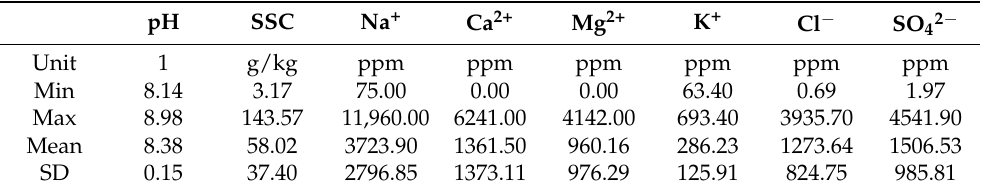
Table 1. Descriptive statistical parameters of the soil pH, SSC, and the contents of Na + , Ca 2+ , Mg 2+ , K + , Cl − , and SO 42 − .